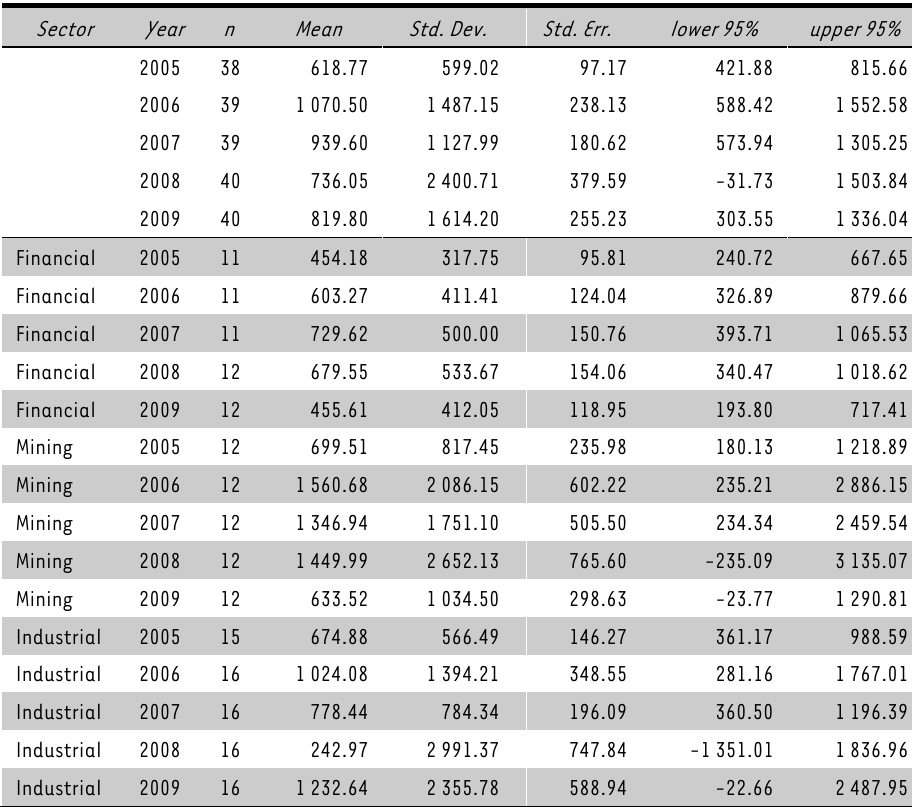
TABLE 11: Descriptive statistics for EPS All figures except for n are given in South African